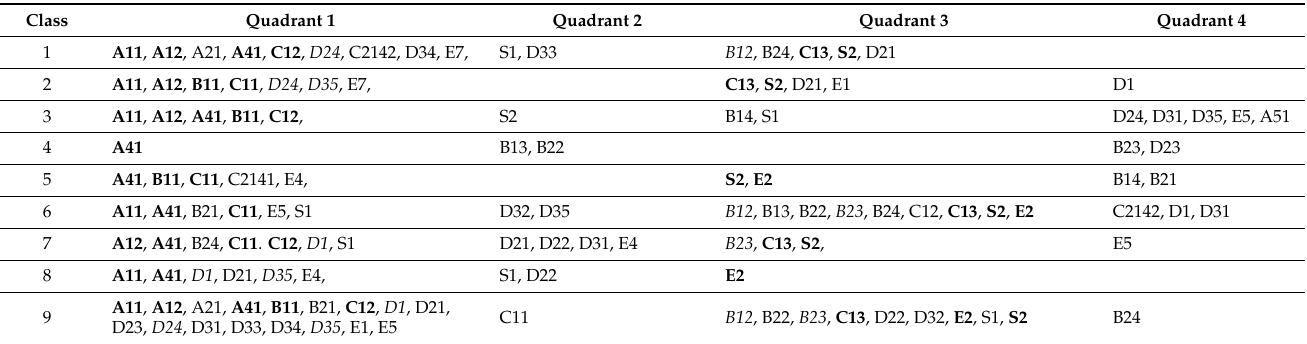
Table 10. Multiple cases: showing awareness of other people’s emotional reactions (A31) as a focal behavior with category selection as conditioned